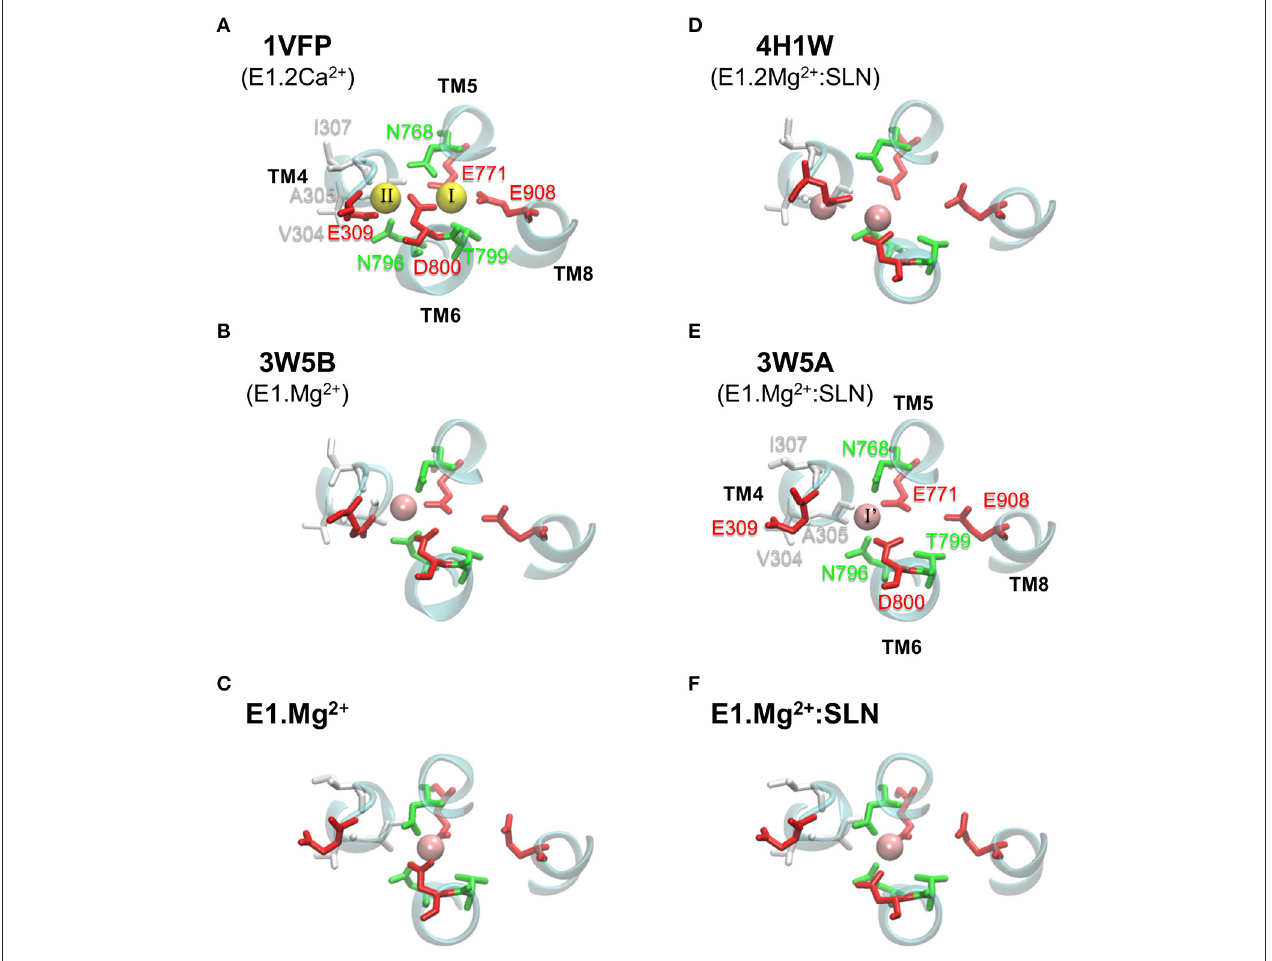
FIGURE 6 | Ca 2 + and Mg 2 + binding sites in various SERCA1a structures. In (A–C) the structures are without SLN, and in (D–F) they are in the presence of SLN. (A , B , D,E) show PDB structures, with the PDB ID written in bold and the corresponding state given below the ID. (C,F) present the two energy-minimized structures, in the absence and presence of SLN, respectively. In each panel, all the residues of the two Ca 2 + binding sites are drawn, even when they are not chelating any ion, as for the structures with Mg 2 + . Ca 2 + and Mg 2 + ions are yellow and pink spheres, respectively. The binding site residues are colored according to their type, acidic: red, polar: green, and hydrophobic: white. (A) In site I, Ca 2 + is chelated by eight oxygen atoms, of which four are from the carboxyl groups of acidic residues (TM5:E771, TM6:D800, and two from TM8:E908), two from the sidechains of polar residues (TM5:N768 and TM6:T799), in addition to two buried water molecules. In site II, Ca 2 + is chelated by seven oxygen atoms, of which only three are from the carboxyl groups of acidic residues (two from TM4:E309 and one from TM6:D800), one is from the sidechain of a polar residue (TM6:N796) and three are from the carbonyl groups of the backbone of hydrophobic residues (TM4:V304, A305 and I307). (E) In 3W5A, Mg 2 + sits in site I’, located between sites I and II and it is exclusively chelated by residues from these two sites, in addition to two water molecules. For clarity, water molecules are omitted and only small parts of helices TM4, TM5, TM6, and TM8 are drawn as cyan cartoons. Also for clarity, we chose to annotate only two structures, one with Ca 2 + (1VFP) and one with Mg 2 +